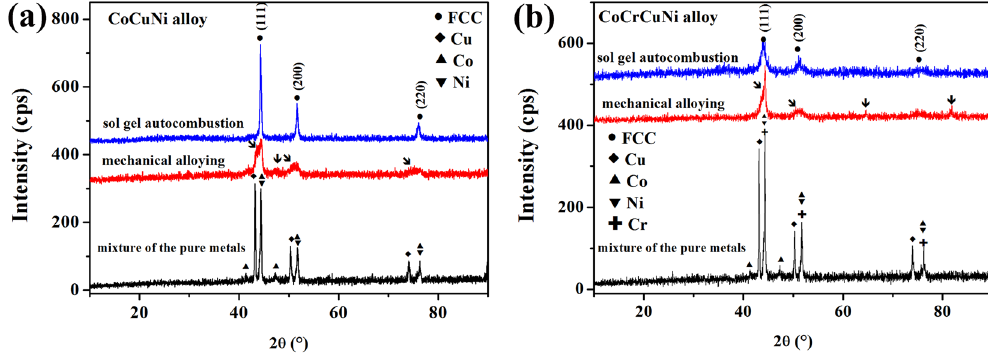
Figure 4. XRD patterns obtained for the equiatomic CoCuNi and CoCrCuNi alloys prepared via sol-gel autocombustion and mechanical alloying, respectively.